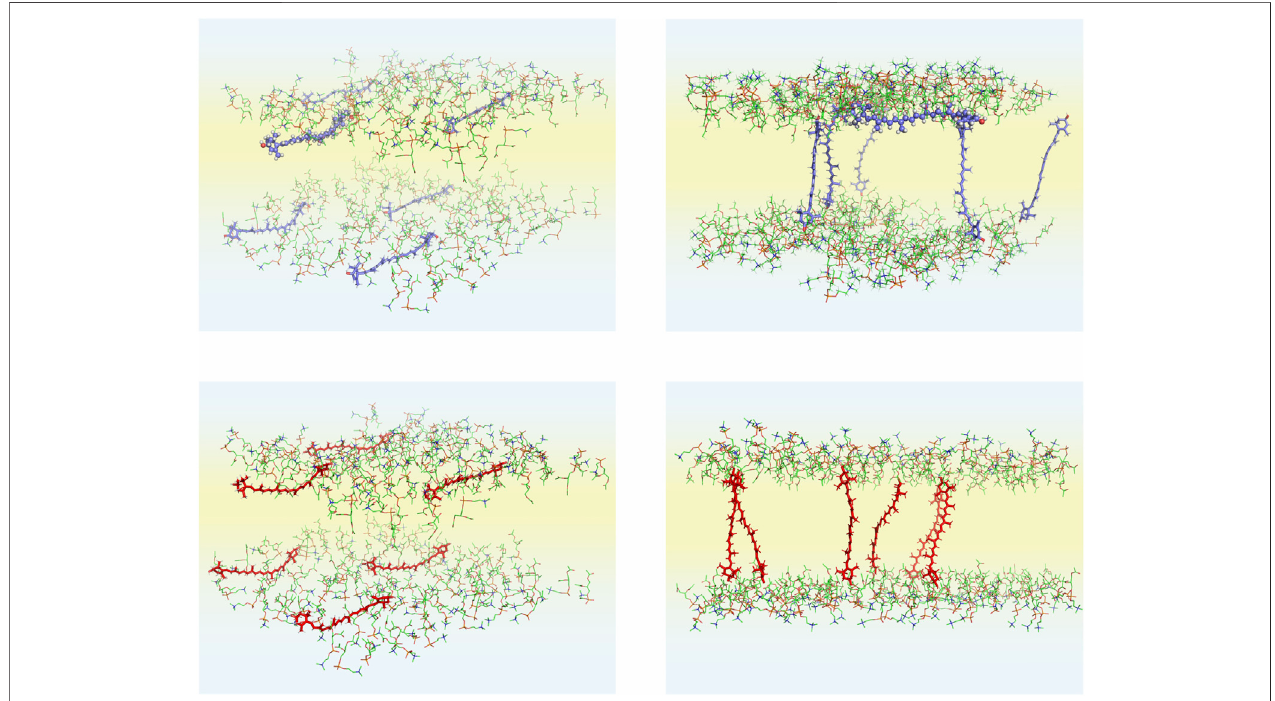
FIGURE2| Initial (leftcolumn) and fi nal (rightcolumn; after1,100 nsofMDsimulations)structures ofthePOPC-LUT_H (upperrow) andPOPC-ZEA_H (lower row) bilayers. Initially, six xanthophyll molecules are placed parallel to the bilayer surface. In the fi gures, only the POPC head groups and xanthophyll molecules are shown; the POPC acyl chains, water molecules and the PC head group hydrogen atoms are removed to better show the details of the systems. The atoms are represented in standard colours, except for the xanthophyll carbon atoms which for are blue for lutein red for zeaxanthin. Water is shaded light blue and the lipid nonpolar region is shaded light yellow . The lutein molecule (#6) that remained in the horizontal position during the whole simulation time of the POPC-LUT_H bilayer is presented in the ball-and-stick model, both in the initial and fi nal states.